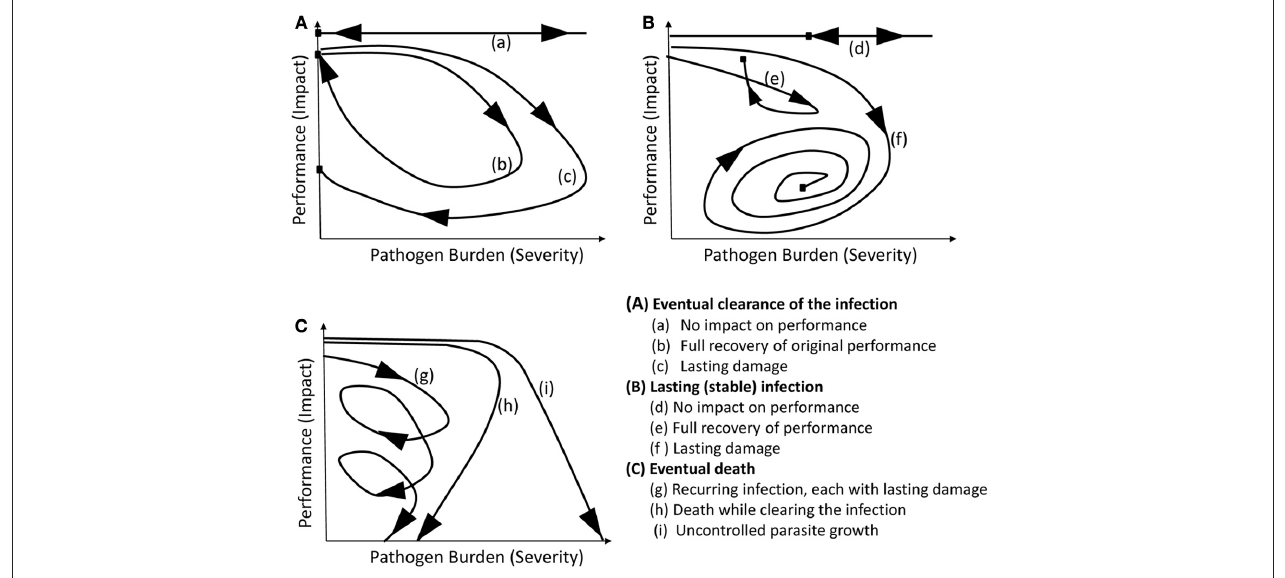
FIGURE 3 | Schematic figure of the nine trajectory archetypes. The three graphs broadly correspond to different resistance categories, while the three individual curves in each graph broadly correspond to different tolerance categories. For further explanation see